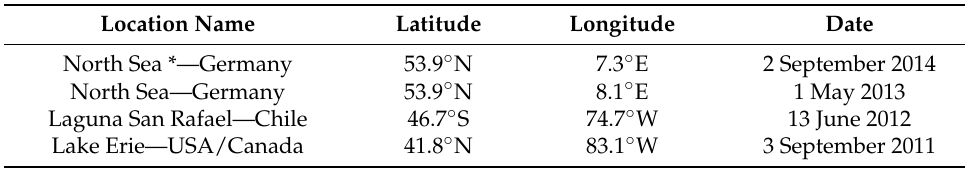
Figure 1. The four HICO scenes used in the analysis: first North Sea scene ( a ), second North Sea scene ( b ), Laguna San Rafael—Chile ( c ), Lake Erie—USA/Canada ( d ). Table 1. Unlabelled Data, from